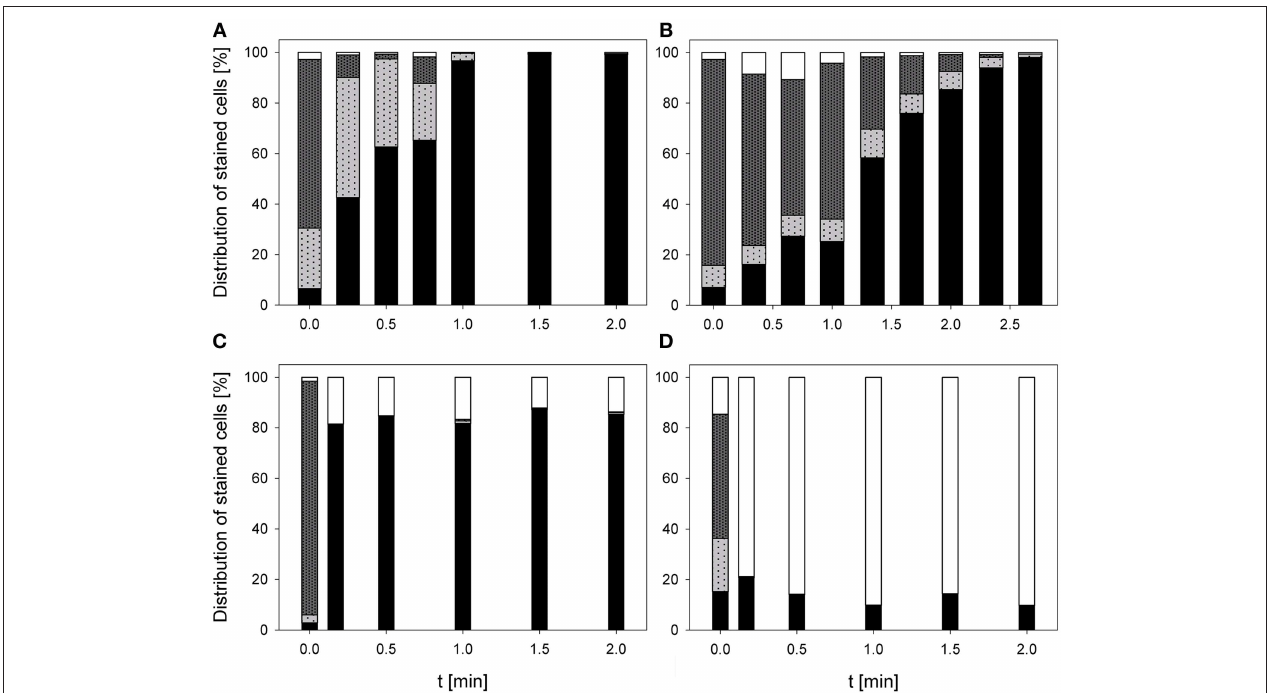
FIGURE 7 | Esterase activity and membrane integrity of P. carotovorum after PAA treatment [(A) 10 ◦ C, 0.25% PAA], CAPP treatment [(B) 20 W], and treatment with ozonated water [(C) 2.8mg l − 1 O 3 (–); (D) 3.8mg l − 1 O 3 ( + )]. Black bars representing permeabilized cells without esterase activity; dotted gray bars representing permeabilized cells with esterase activity, dotted light gray bar representing intact cells with esterase activity, and white bars representing cells without fluorescence/cell